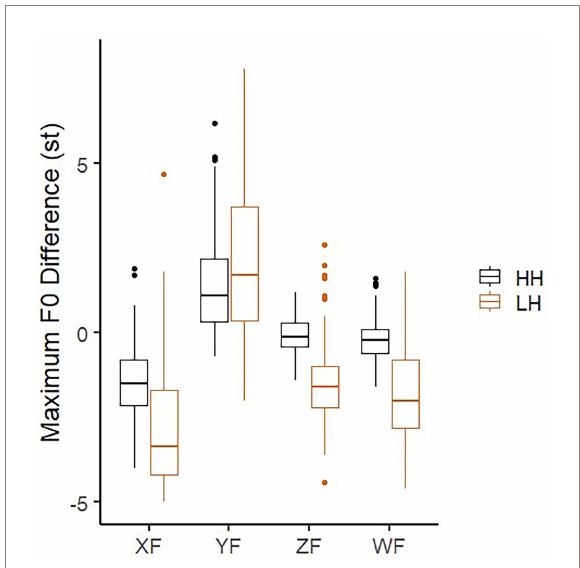
FIGURE 7 Maximum F0 difference between the two H tones surrounding syllable X (either L or H) in different focus conditions, while the two boundary conditions are averaged.